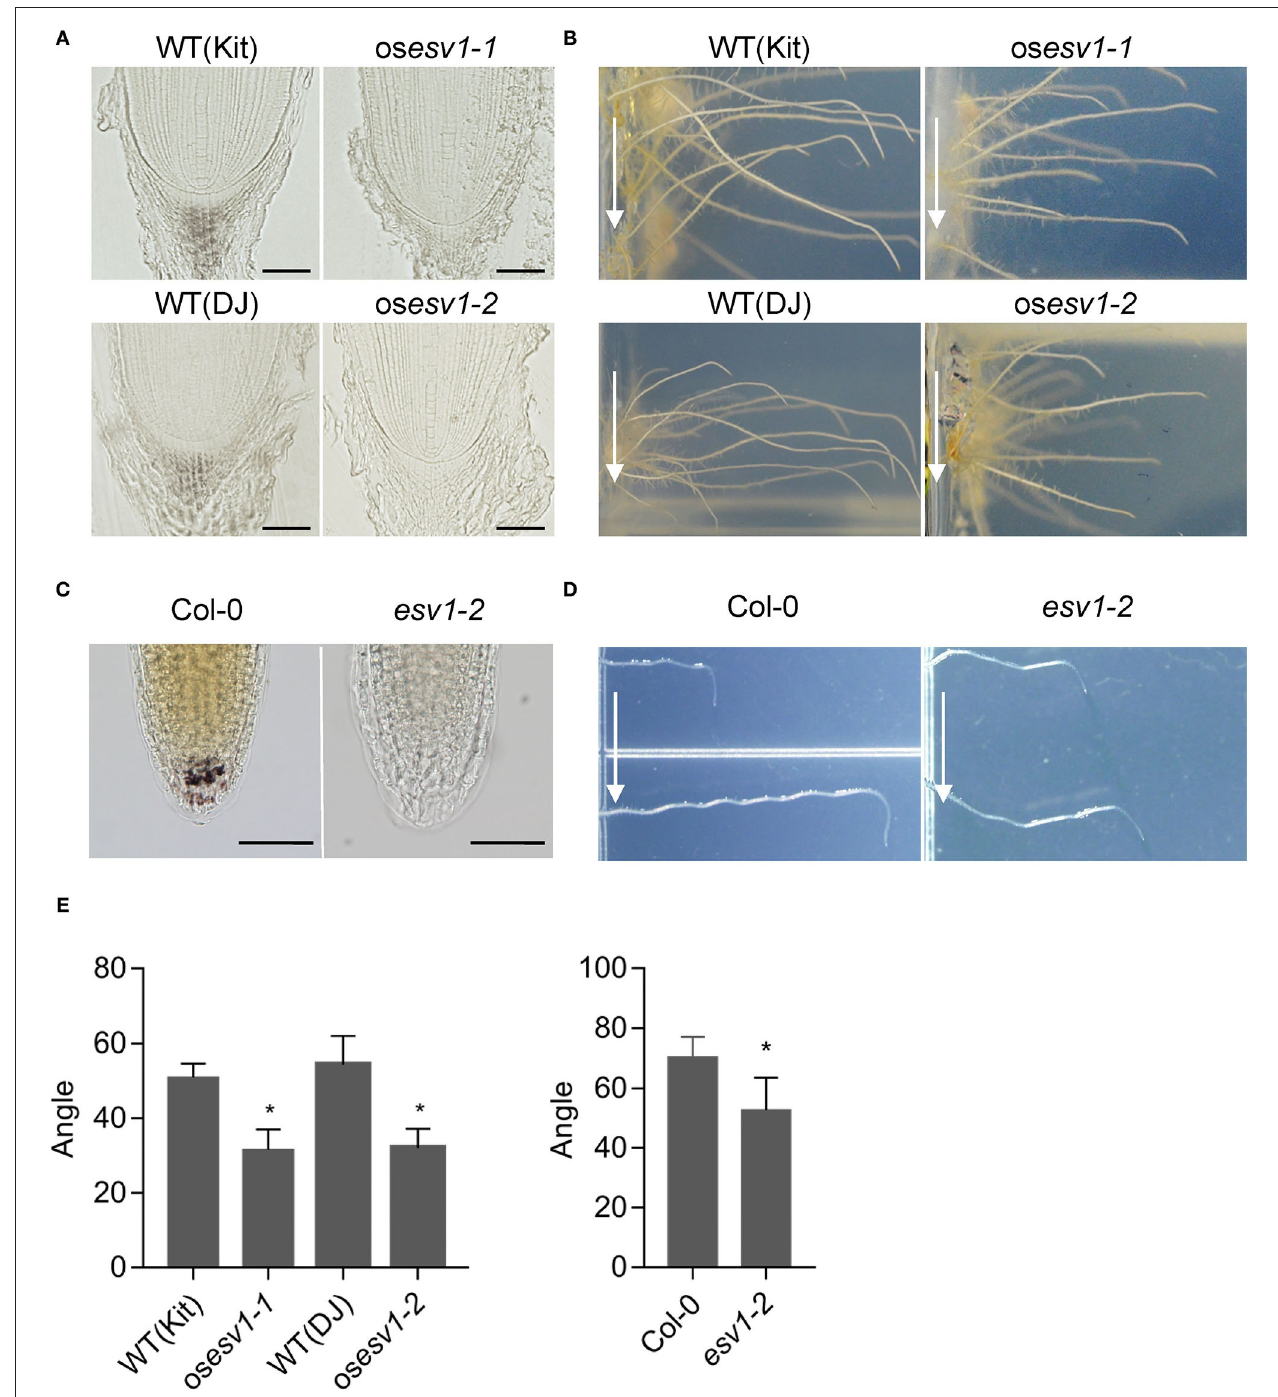
FIGURE 7 | ESV1 promotes root gravitropism by forming root columella starch granules both in Arabidopsis and rice. (A) Absence of root columella starch granules in rice ESV1 mutants. Root tips were embedded in resin and starch granules were visualized by staining with Lugol’s iodine. DJ (Dongjin) and Kit (Kitaake) in parenthesis indicate the respective rice cultivars. Scale bar = 50 µ m. (B) Reduced root gravitropic responses of rice ESV1 mutants. Rice seedlings grown on MS-agar for 5 days in the dark were rotated by 90 degrees and grown one more day before taking images to measure bending angles. Arrows indicate the direction of gravity after the rotation. The degree of root gravitropism is presented as the degree of root bending. (C) Absence of root columella starch granules in Arabidopsis ESV1 mutant. Root columella starch granules were visualized by staining 3-day-old dark-grown seedlings with Lugol’s iodine. Scale bar = 50 µ m. (D) Reduced root gravitropic response in Arabidopsis ESV1 mutants. Arabidopsis seedlings grown on MS-agar for 5 days in the dark were rotated by 90 degrees and grown 12 more hours before taking images to measure the angle of bending. Arrows indicate the direction of gravity after the rotation. The degree of root gravitropism is presented as the degree of root bending. (E) Quantitation of root gravitropic responses in rice and Arabidopsis. Seedlings were grown as in (B,D) . Asterisks indicate significant differences from wild type (* p < 0.05; Student’s t -test). Error bars = SD ( n = 10 for Rice, n = 100 for Arabidopsis).